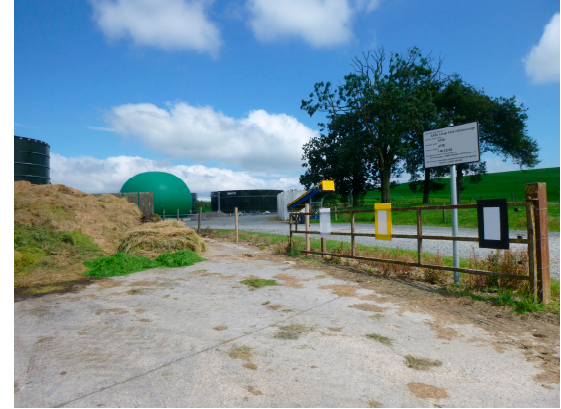
Figure 1. The basic experimental design, showing white sticky traps on white, yellow or black Corriboard ® frames mounted on pre-existing structures and positioned close to likely S. calcitrans habitats within a livestock-rearing farmyard. This is site 1 as described in the main text.